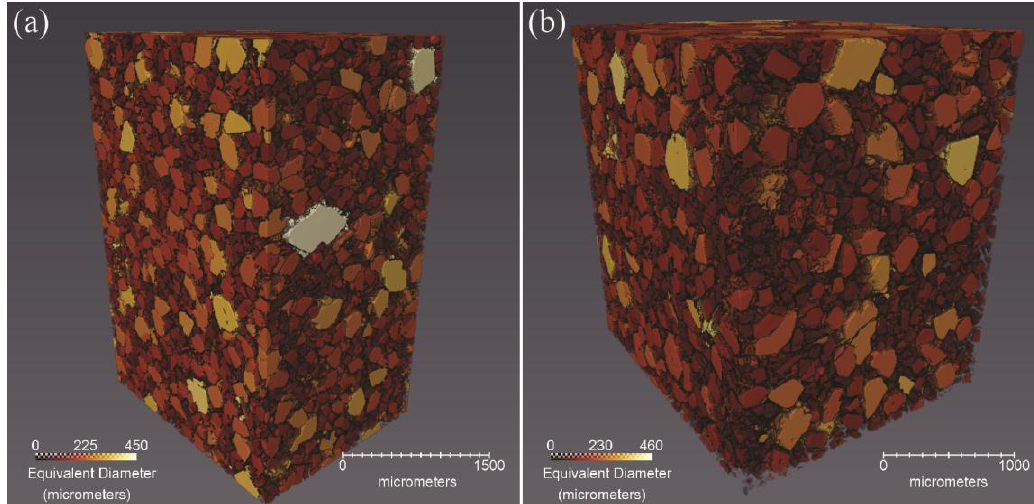
Figure 8. Volume rendering of CF75L ( a ) and CF75H ( b ), showing the HMX crystals colored by equivalent diameters. Larger crystals are lighter in